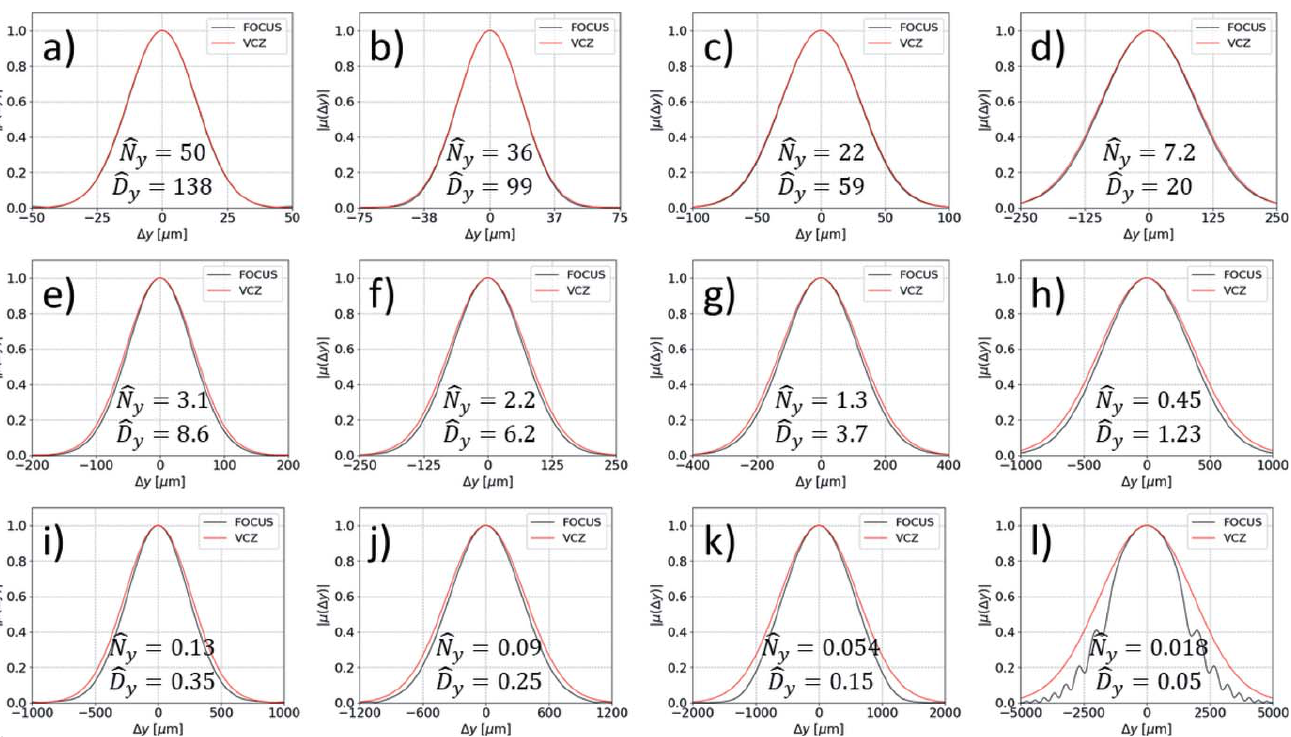
Figure 4 Systematic study of the vertical coherence for a typical third-generation synchrotron light source for radiation tuned at the harmonic h = 7 with (cid:2) = 0.1 nm ( a , e , i ), h = 5 with (cid:2) = 0.14 nm ( b , f , j ), h = 3 with (cid:2) = 0.23 nm ( c , g , k ), and h = 1 with (cid:2) = 0.7 nm ( d , h , l ), and for decreasing vertical beam size (cid:11) y = 40 m m ( a , b , c , d ), (cid:11) y = 10 m m ( e , f , g , h ), and (cid:11) y = 2 m m ( i , j , k , l ). Predictions based on the van Cittert and Zernike theorem (VCZ) are also reported for direct comparison. The electron beam divergence is varied according to (cid:11) 0 In each plot we also report the corresponding normalized parameters ^ NN